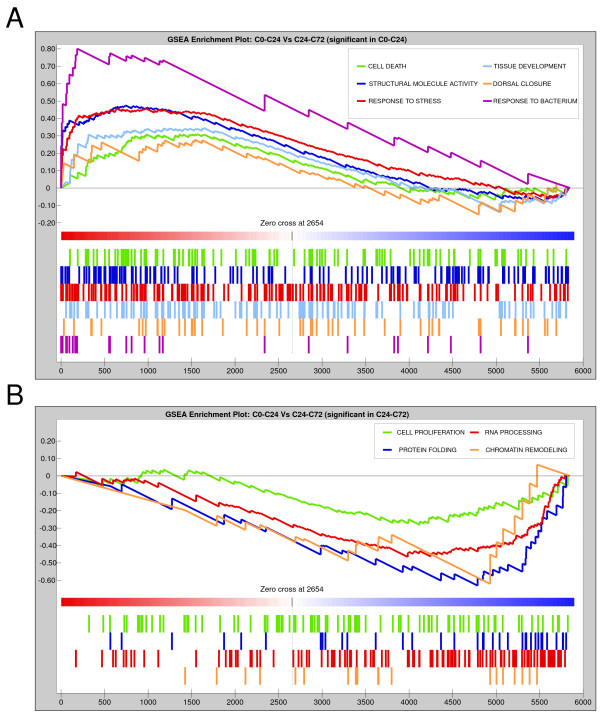
Gene set enrichment analysis of differentially expressed genes in wing imaginal discs at 24 and 72 hours of regeneration. (A) Enrichment plots for statistically significant GO categories in C0→C24. ES value reaches its absolute peak on the left side of the enrichment plot, indicating overrepresentation of these categories compared with C24→C72. (B) Enrichment plots for statistically significant GO categories in C24→C72. ES value reaches its absolute peak on the right side of the enrichment plot, indicating overrepresentation of these categories compared with C0→C24. Genes in each GO category ranked according to their expression values in both time points are shown as coloured bars. The zero cross mark indicates the point in which the difference between expression in C0→C24 and C24→C72 is 0.